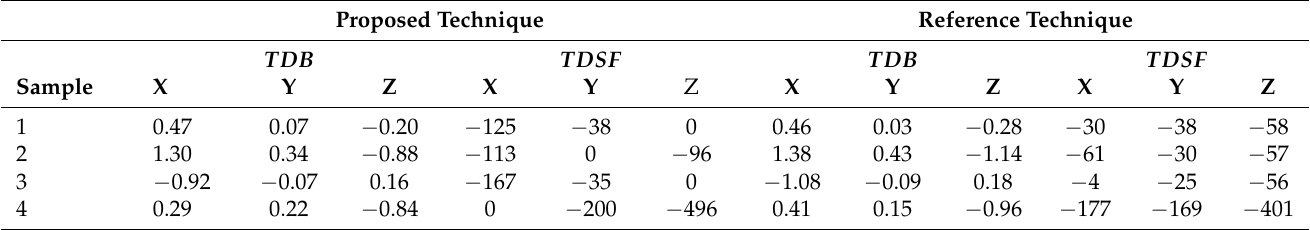
Figure 13. Comparison between the TDB values obtained with both techniques. Table 6. TDB and TDSF value obtained for all the samples and axes with both